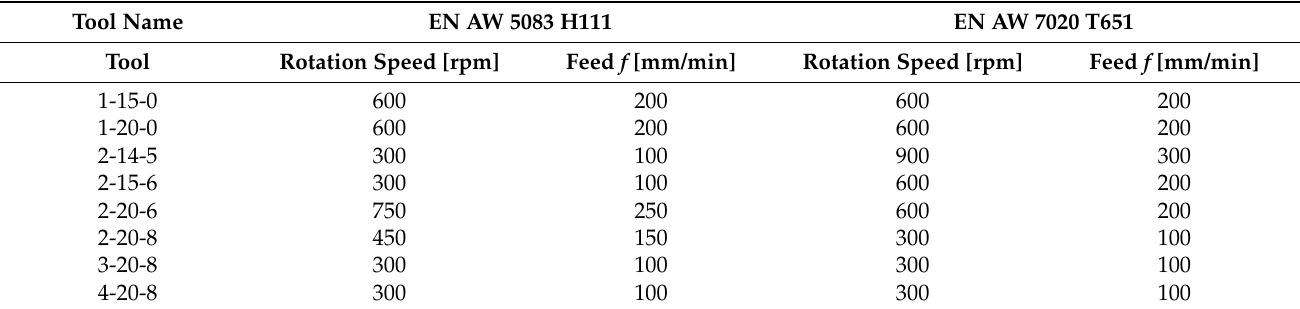
Table 6. Speed n and feed rate f for individual tools as a result of parameter determination. Tool